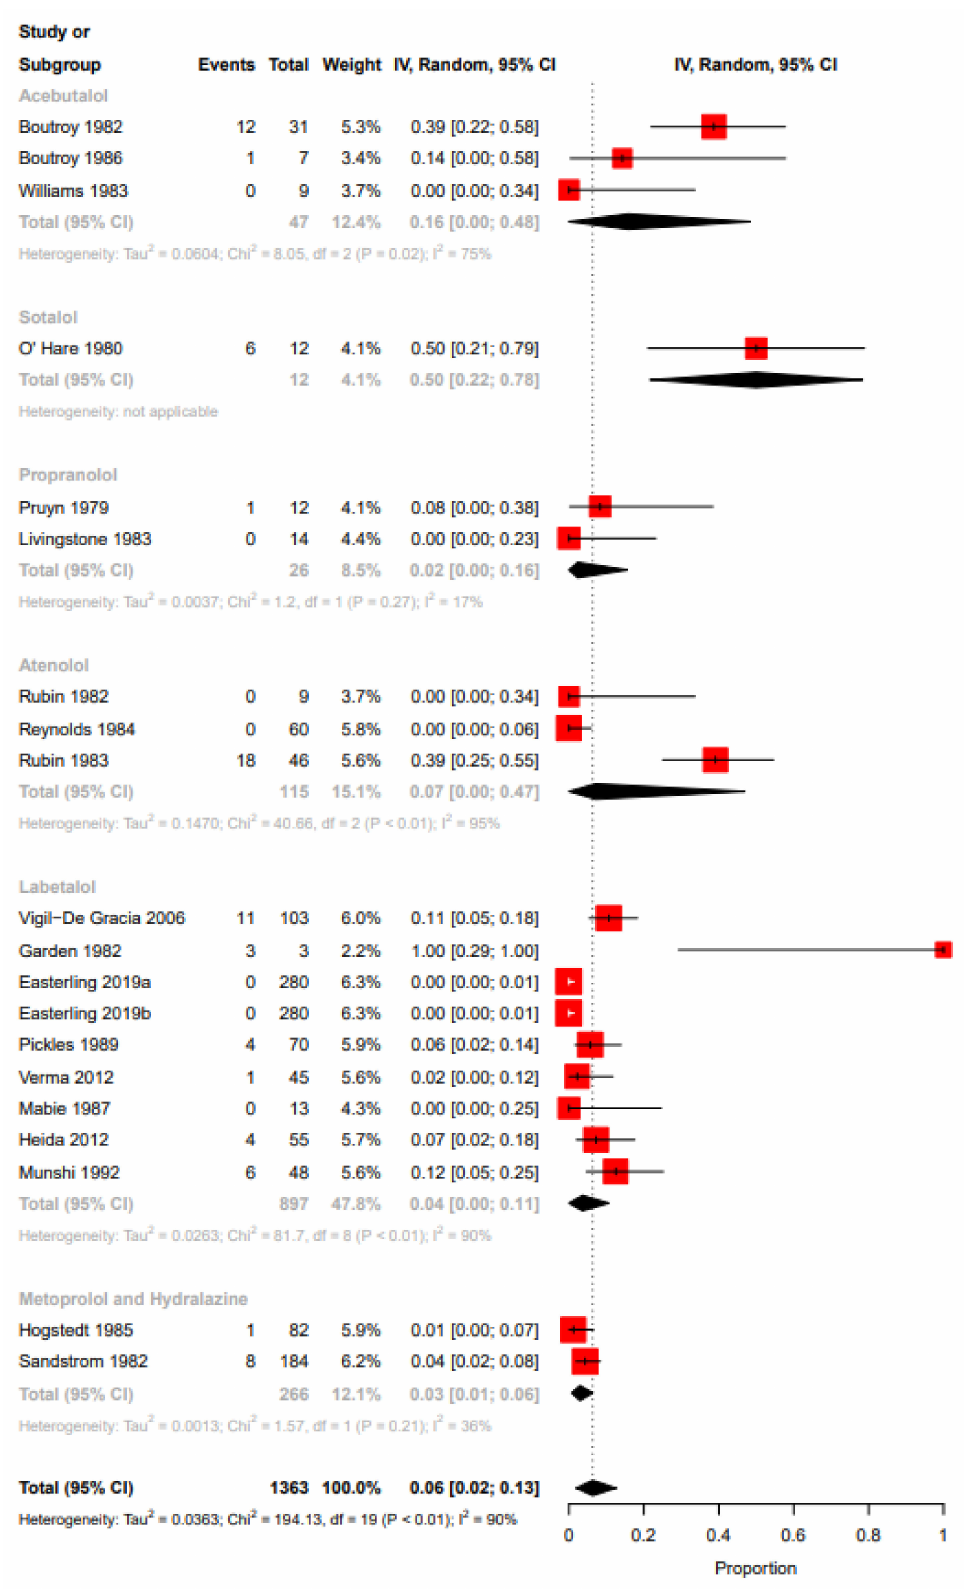
Figure 5. Proportion-based meta-analysis